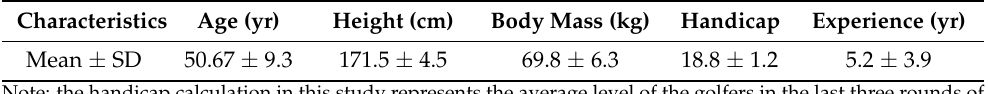
Table 1. Subject characteristics (N =